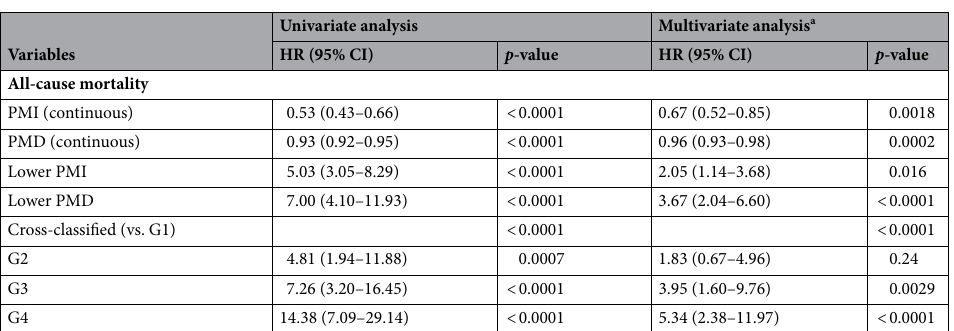
Table 3. Cox proportional hazards analysis of the psoas muscle index and psoas muscle density for all-cause mortality. HR hazard ratio, PMI psoas muscle index, PMD psoas muscle density, G1 higher PMI and higher PMD, G2 lower PMI and higher PMD, G3 higher PMI and lower PMD, G4 lower PMI and lower PMD. a Adjusted by gender and age, history of cardiovascular disease, geriatric nutritional risk index, simplified creatinine index, and log of C-reactive protein level.